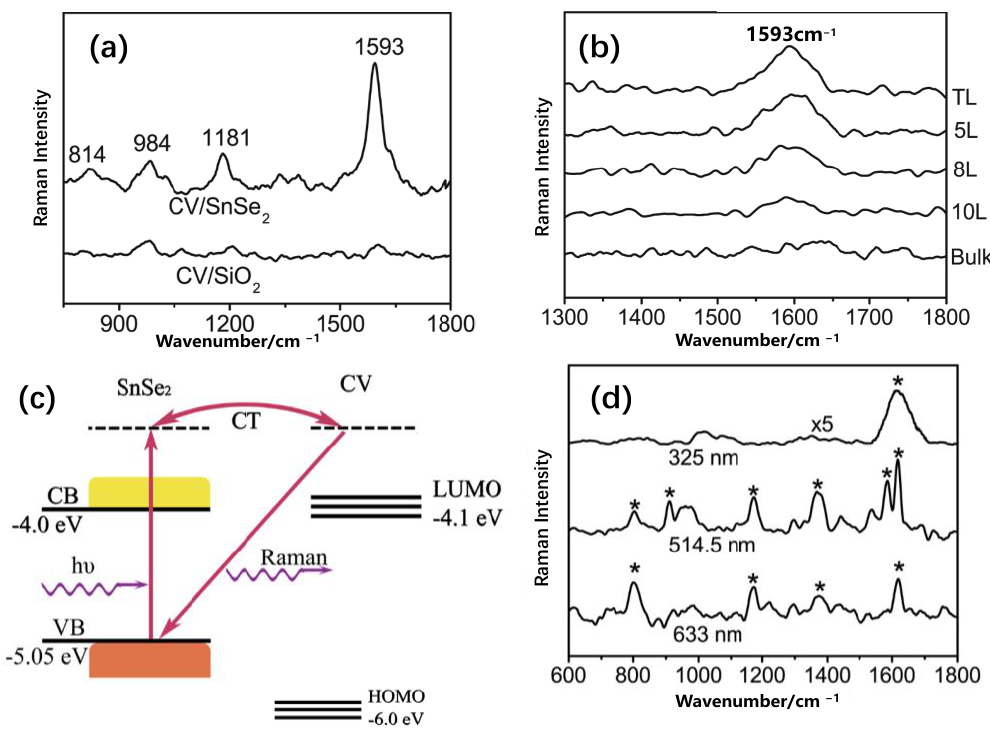
Figure 8. ( a ) Raman spectra of the CV molecules (10 − 4 mol/L) on the blank SiO 2 /Si substrate and SnSe 2 substrates. All of the Raman signals were excited by a 325 nm laser. ( b ) Raman spectra of CV molecules (10 − 6 mol/L) on the SnSe 2 substrate with different thicknesses. ( c ) The energy level and charge–transfer process diagram of triple layers SnSe 2 nanoflakes and CV molecules. ( d ) Comparisons of the UV–SERS signals of CV (10 − 6 mol/L) on the SnSe 2 substrate with 632.8, 514.5, and 325 nm excitation. The Raman band for CV was marked by a star (*). Reprinted from Ref. [100] with permission of 2019 Wiley Online Library.